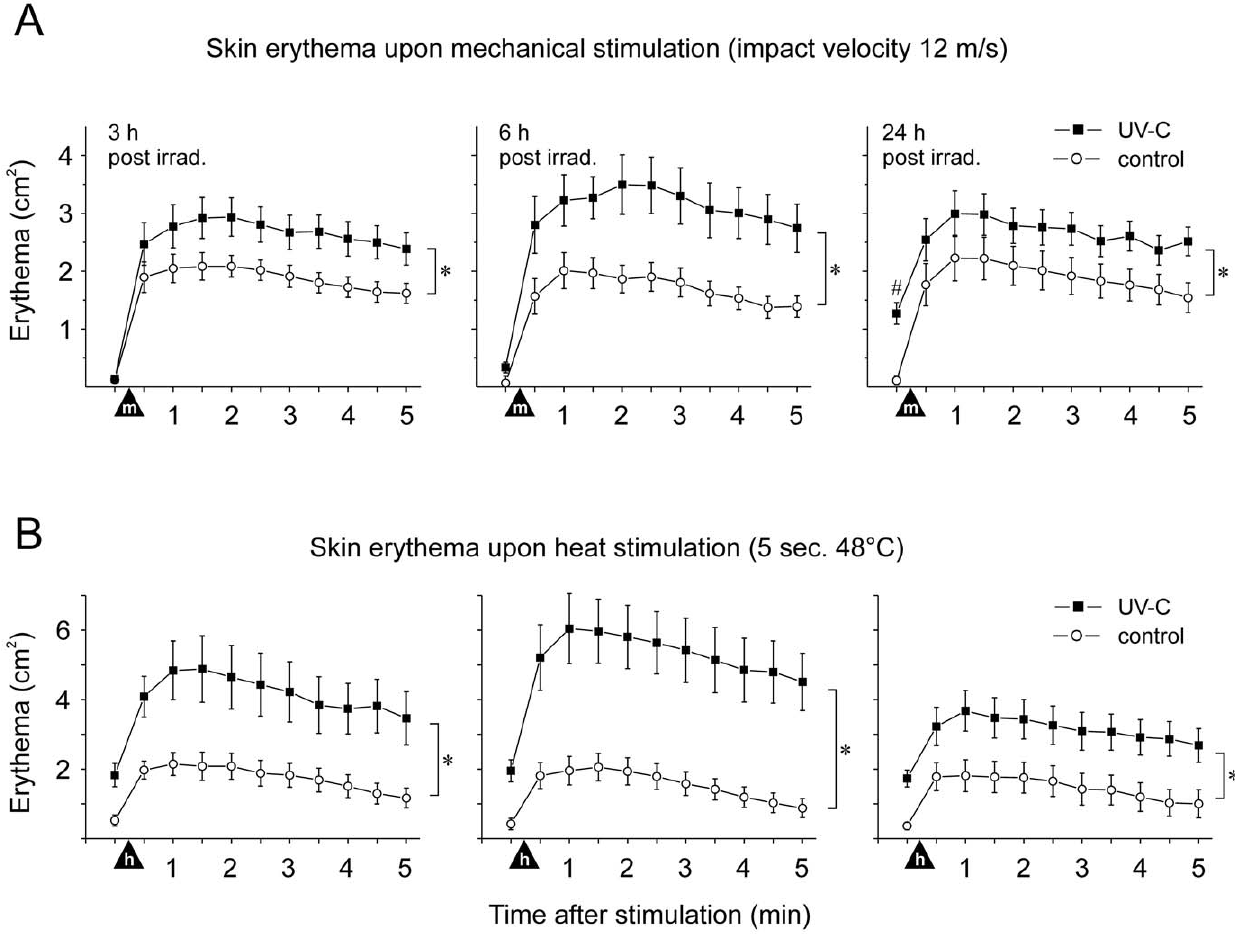
Figure 2. Time course of skin erythema development (cm 2 ) upon (A) mechanical and (B) heat stimuli. Responses to mechanical impact stimuli (12 m/s) and continuous heat (5 sec at 48 C) were recorded from untreated control (open circles) and UV-C treated skin (5-fold MED, solid squares) at 3 h (left), 6 h (middle) and 24 h (right panel) post irradiation. The hatch indicates significantly increased blood flow 24 h after UV-C irradiation (p , 0.0001, Fishers LSD test), filled triangles indicate the time of stimulation (m: mechanical, h: heat), and asterisks indicate significant differences between control and UV-C skin (p , 0.0001, Fishers LSD test). Note that heat tests were performed post mechanical stimulation that had caused slightly increased baseline